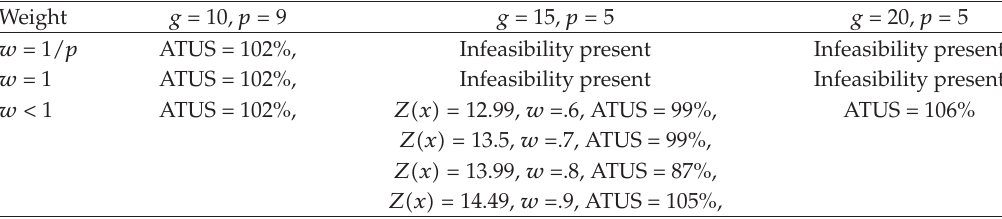
Table 1: Solution of fuzzy fractional goal programming problem by proposed method